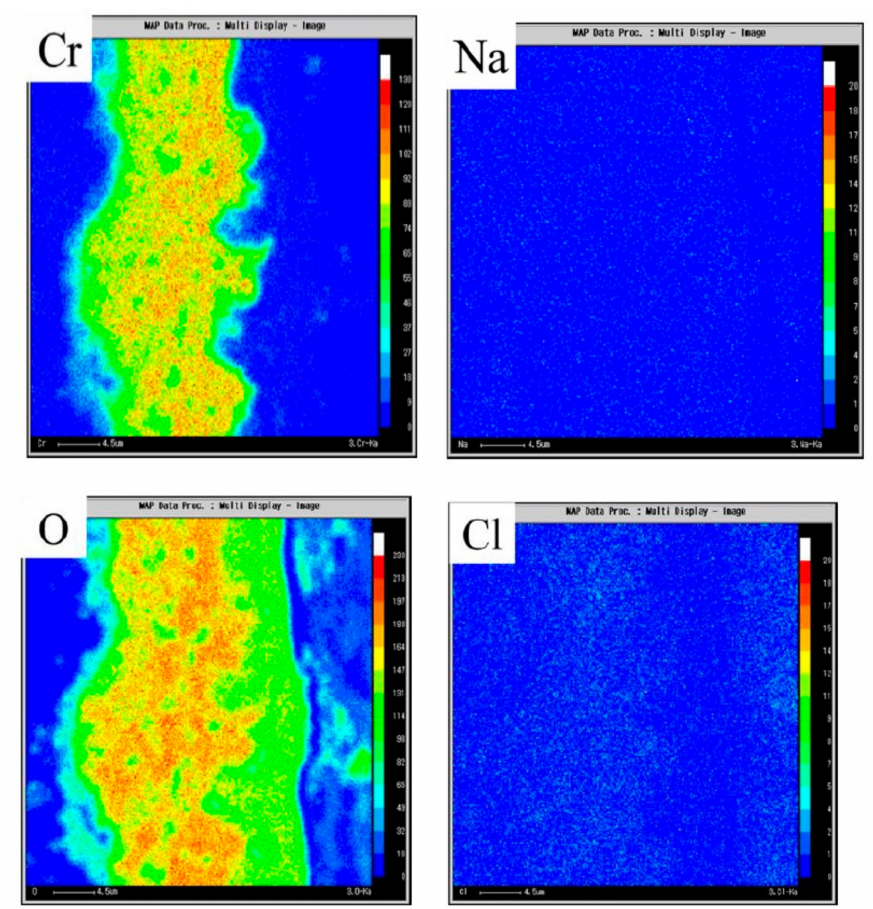
Figure 7. EPMA images of corrosion products after ( a ) No. 1.5 cycle and ( b ) No. 2.5